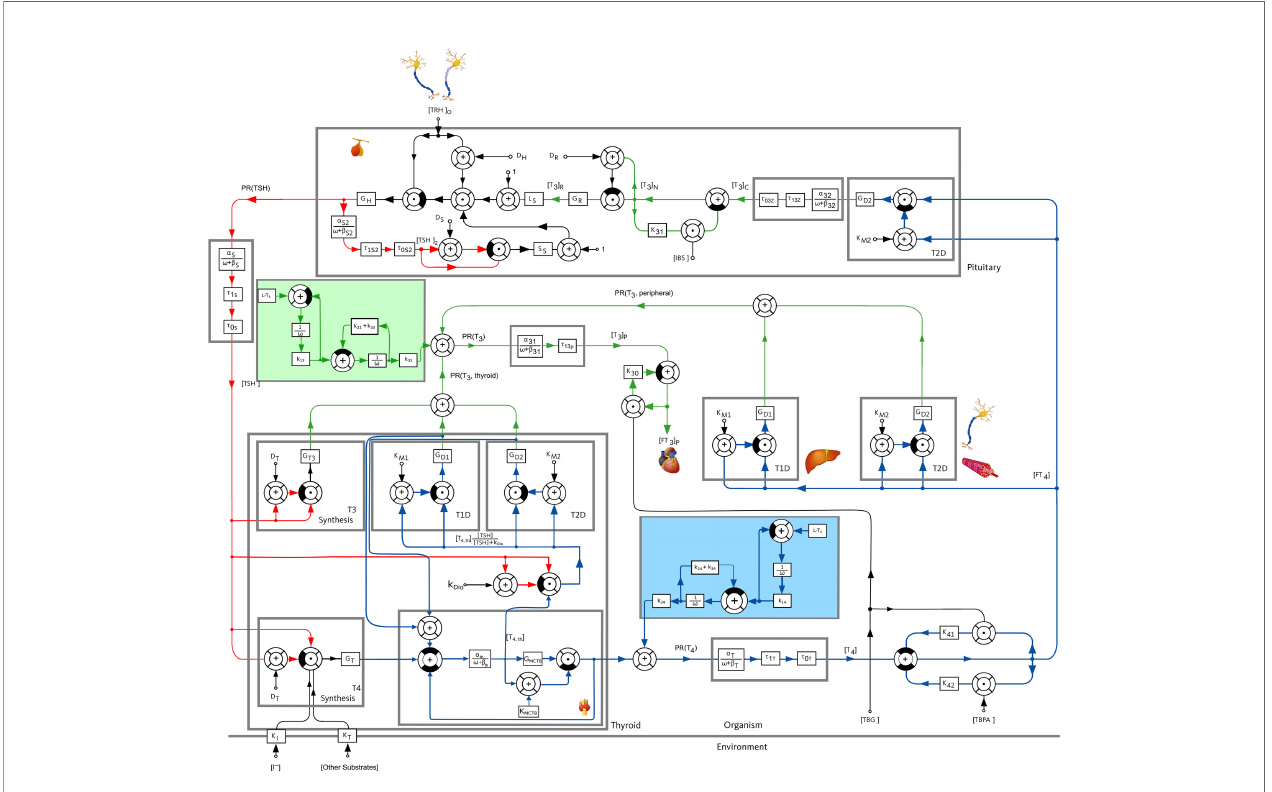
FIGURE 1 | Block diagram of the pituitary-thyroid feedback loop. A detailed explanation of the model is given in (20, Supplementary Material). The underlying differential equations are shown in Section S1 of the Supplementary Material and the numerical parameter values are given in Section S4 of the Supplementary Material. The extensions of the mathematical model compared to the previous versions of the model, see (15, 19, 20), are shown by a slight blue and a slight green background